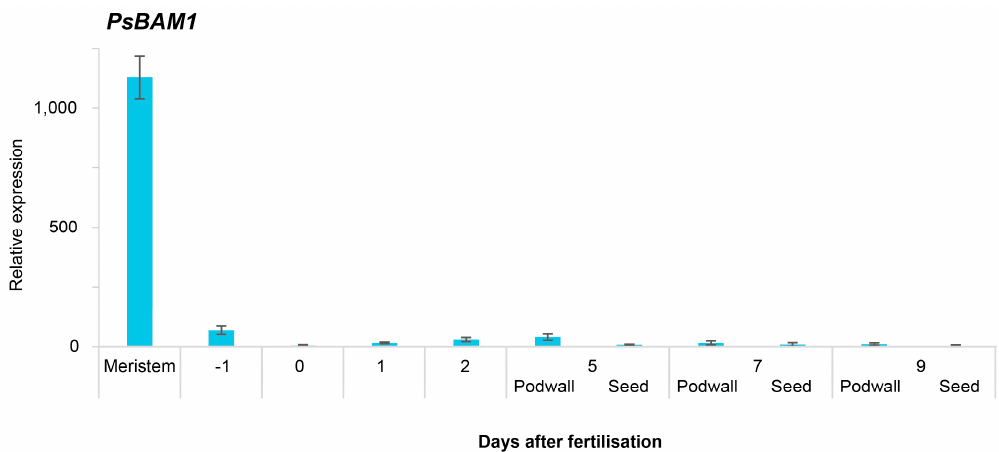
Figure 5. Expression of WUSCHEL and BAM1 in tissue enriched with shoot apical meristems of P. sativum L. cv Bolero. Samples at − 1, 0, 1 and 2 DAF included the entire fruit; Samples at 5, 7 and 9 DAF included pod walls separated from the seeds. The seed sample included cotyledon plus seed coat. Data are from RT-qPCR and are given as fold-change relative to reference genes PsEF , PsGAP , and PsACT . The results are expressed as ± SD.